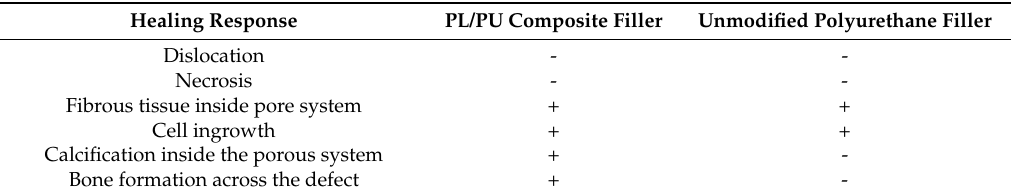
Table 2. Summary of healing response of composite and un-modified polyurethane filler in critical-sized bone defect.